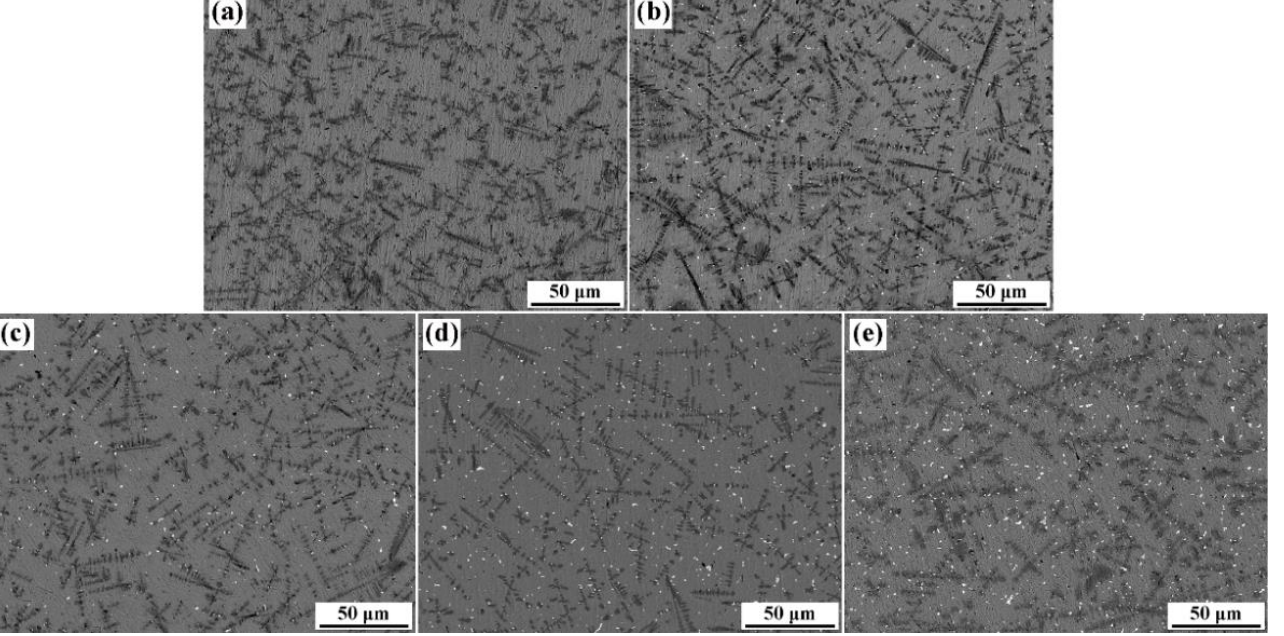
Figure 5. The BSE image of the microstructure in the cladding zone of the composite coating: ( a ) without CeO 2 ; ( b ) 1 wt.% CeO 2 ; ( c ) 2 wt.% CeO 2 ; ( d ) 3 wt.% CeO 2 ;( e ) 4 wt.% CeO 2 .